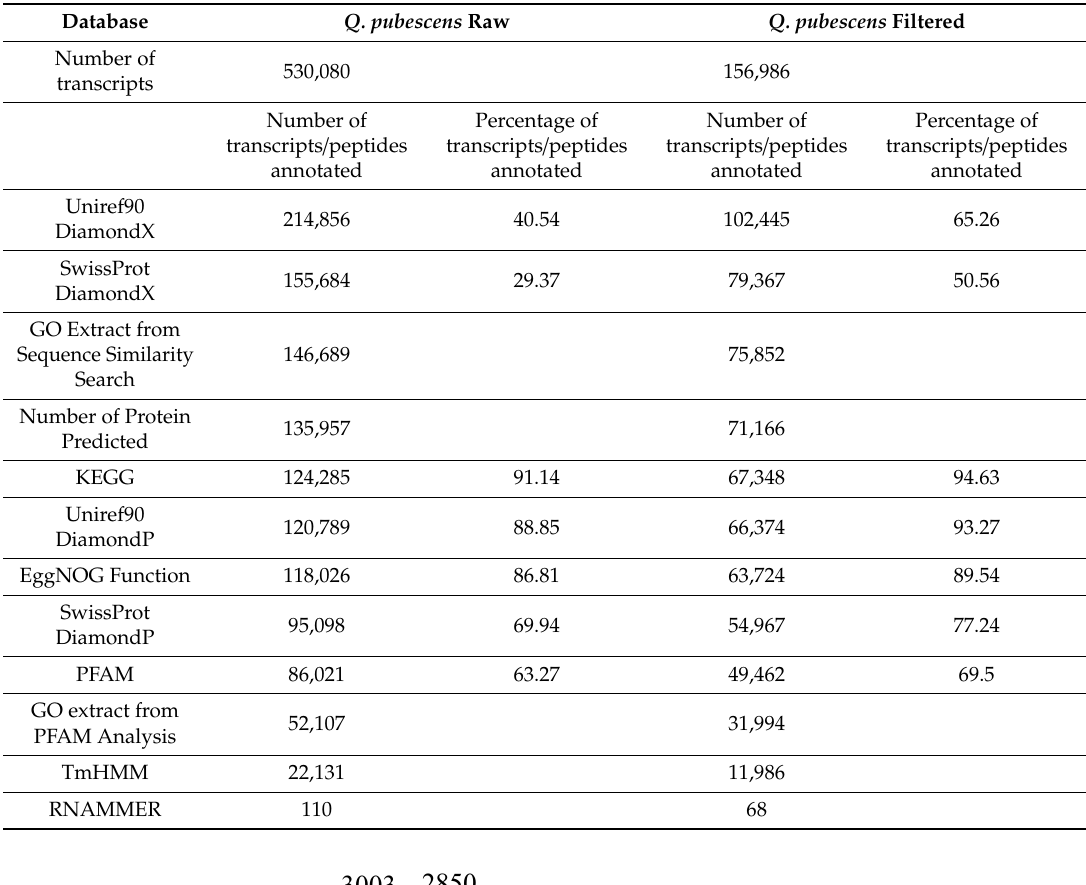
Table 3. Summary of annotations of raw and filtered Q. pubescens genome-guided sequence assembly. KEGG (Kyoto Encyclopedia of Genes and Genomes); eggNOG database (evolutionary genealogy of genes: Non-supervised Orthologous Groups); PFAM (Protein family); TMHMM Transmembrane Helices Hidden Markov Models; RNAmmer (consistent and rapid annotation of ribosomal RNA genes).